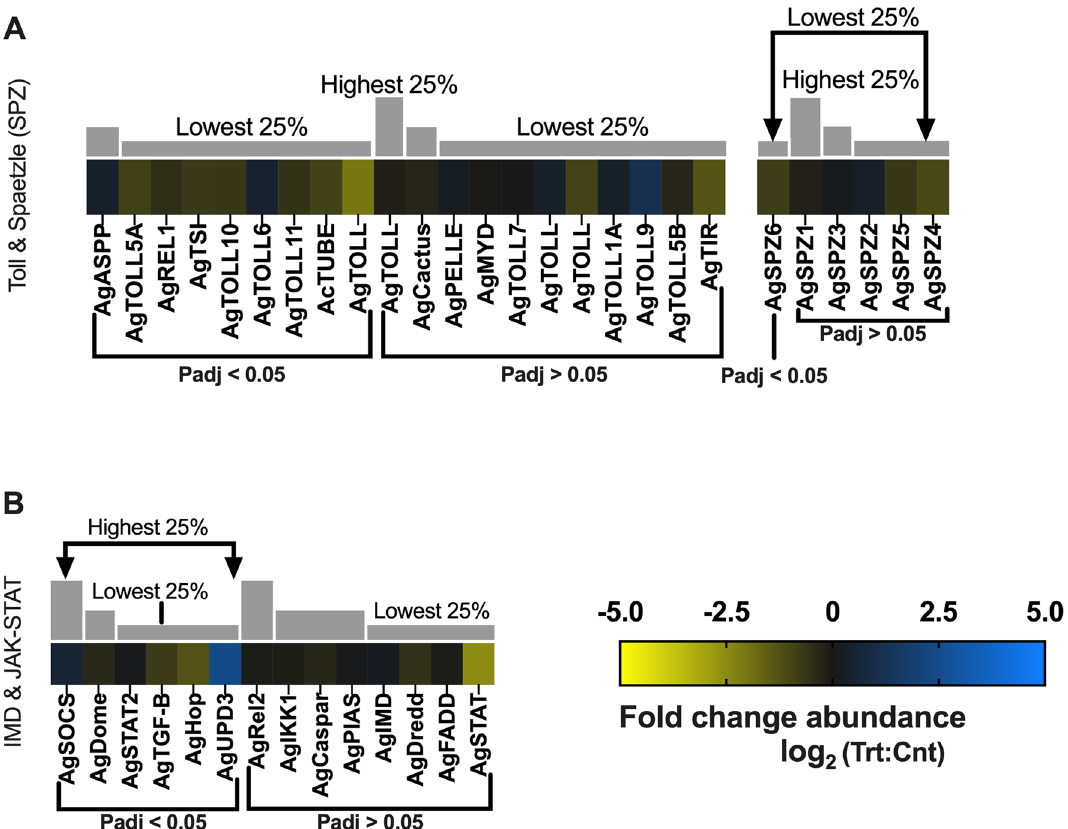
Figure 11. Immune response differential transcript abundances following relevant sporozoite infections. Immune response transcripts that were present at significantly higher (blue) or lower (yellow) levels in Plasmodium falciparum sporozoite infected treatments; non-differentially expressed immune response transcripts are denoted as zeros (black). Immune response genes within each group organized by adjusted p-value and subsequently arrayed left to right from most abundant to least abundant based on FPKM values (quartile bars above each image). ( A ) Toll and spaetzle proteins (SPZ). ( B ). IMD and JAK-STAT proteins. Log 2 scale indicates transcript abundances that were significantly higher (blue) or lower (yellow) in sporozoite infected treatments (Trt) vs. naïve controls NOS 72 . Transcripts for AgSOCS (0.58-fold; p-adj = 0.008; AGAP029624) and AgUPD3 (2.39-fold; p-adj = 0.007; AGAP013506) were significantly more abundant in treatment groups, and AgDome (− 0.33-fold; p-adj = 0.006; AGAP029053), AgHop (− 1.26-fold; p-adj = 0.003; AGAP008354; JAK homolog) and AgSTAT2 (− 0.31-fold; p-adj = 0.02; AGAP000099) were significantly under-represented compared with uninfected controls (Fig. 11B). As is the case for IMD pathways, anopheline JAK-STAT signaling primarily targets pre-sporozoite stages of Plas- modium , making the lack of JAK-STAT activation in the salivary-gland-stage infected An. gambiae examined here expected 80 . This is particularly evident by the significant abundance of JAK-STAT’s primary negative regulator